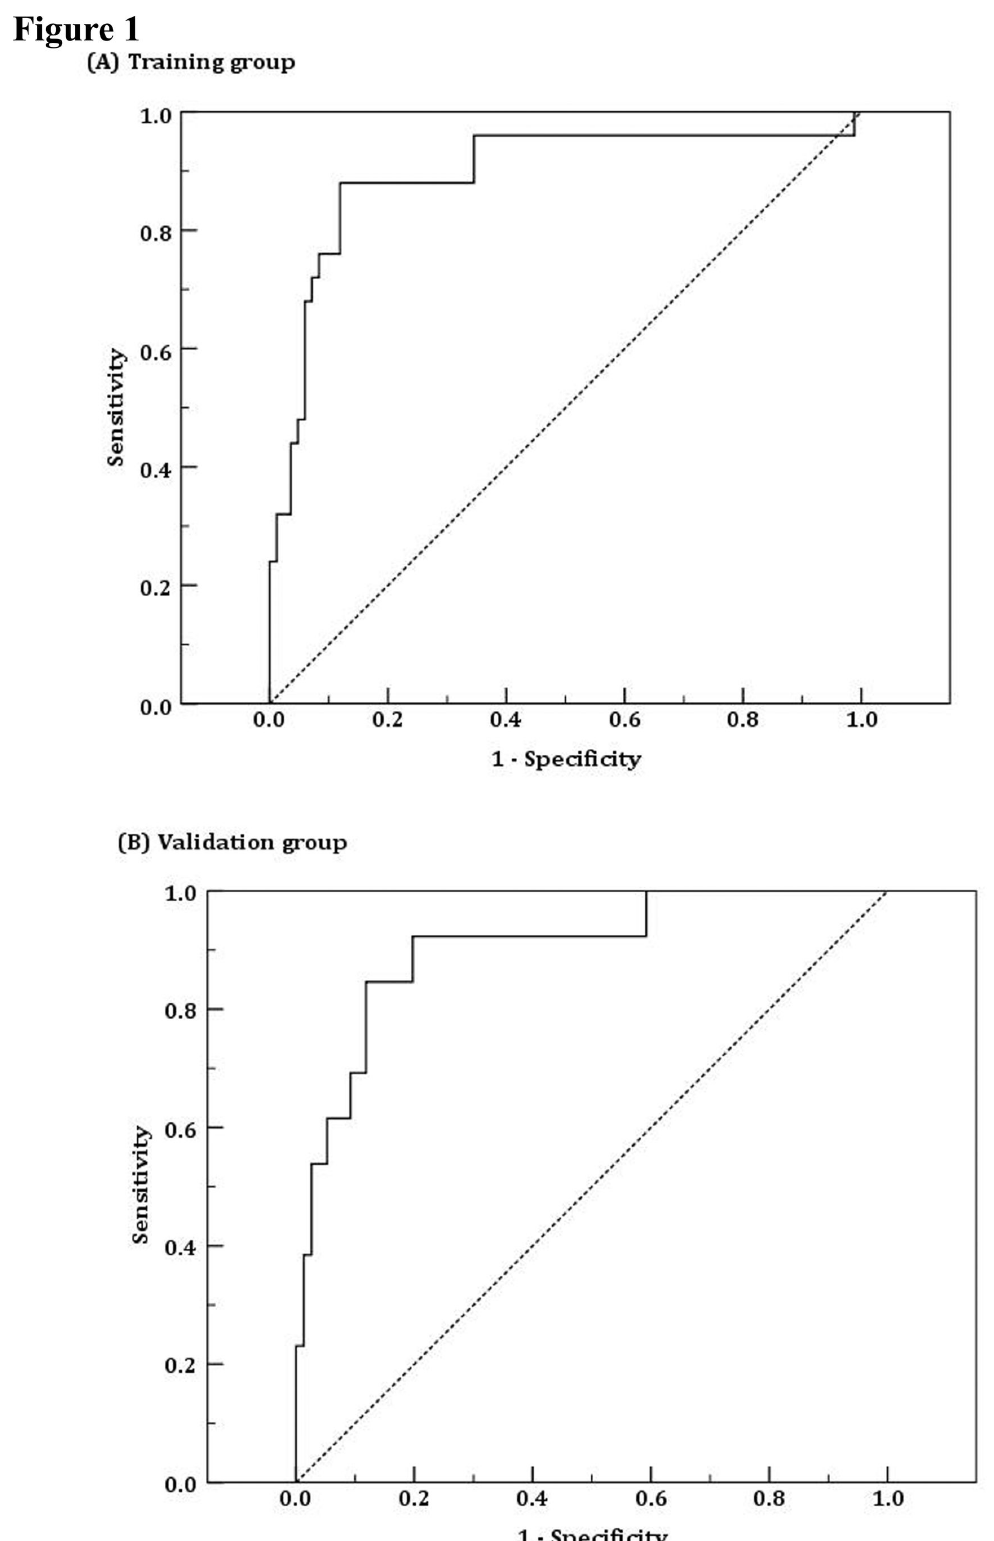
Figure 1. ROC curve of APPCI model in training (A) and validation (B) groups, respectively.